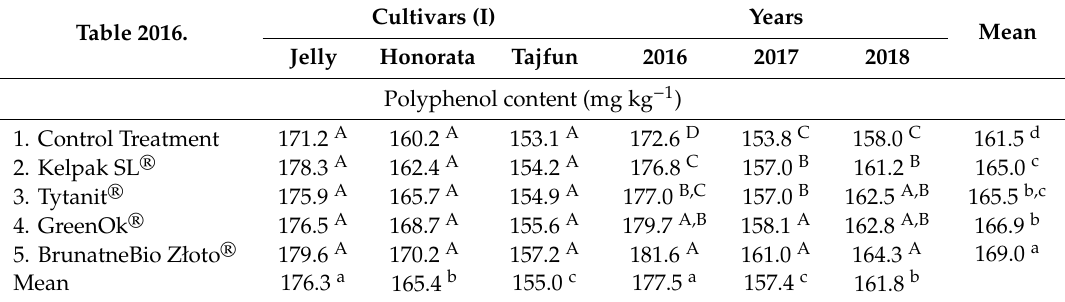
Table 5. Content of polyphenols in the fresh mass of potato tubers (mg · kg − 1 ). Table 2016.